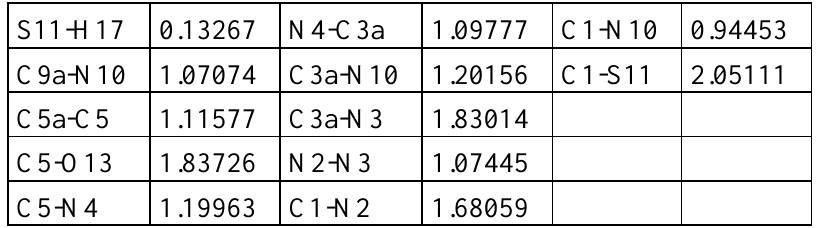
Table 3. Bond orders in the anion form of 1